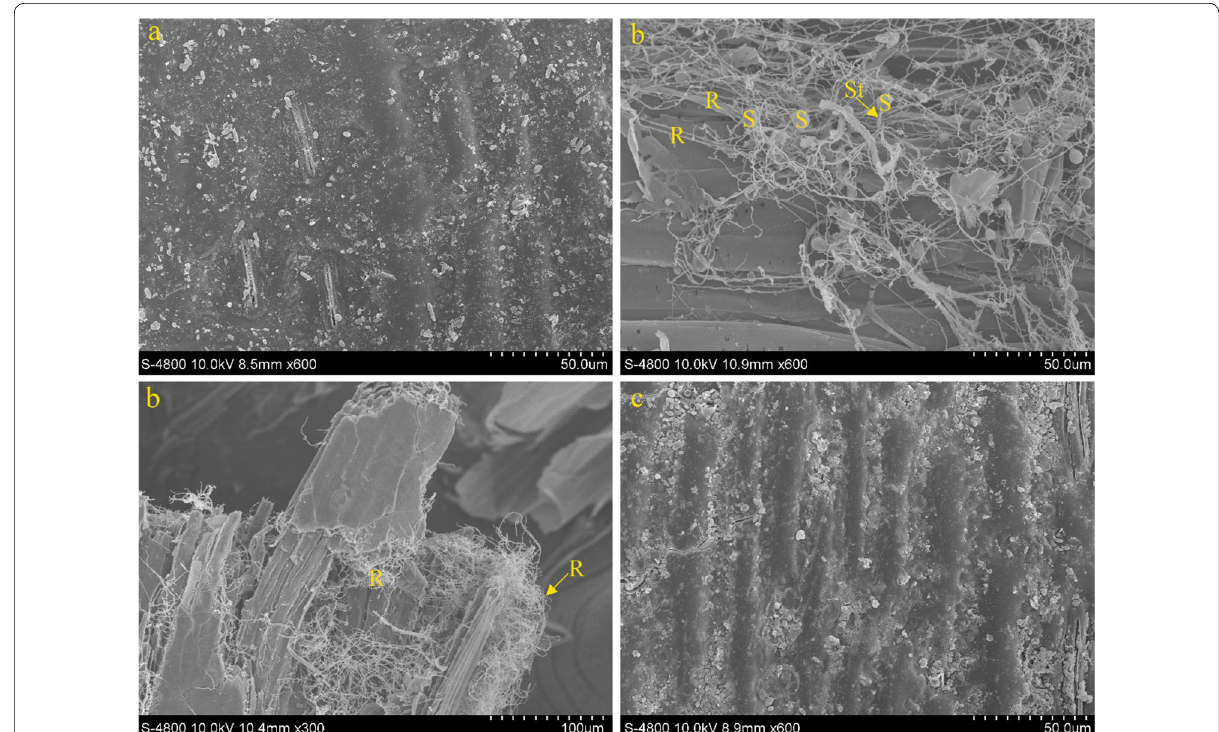
Fig. 1 Images of scanning electron micrograph of whole crop maize silage on 10 days ensilaging. S, fungus sporangium; St, fungus sporangiophore; R, fungus rhizoid. a Control; b fungus addition; c compound enzyme